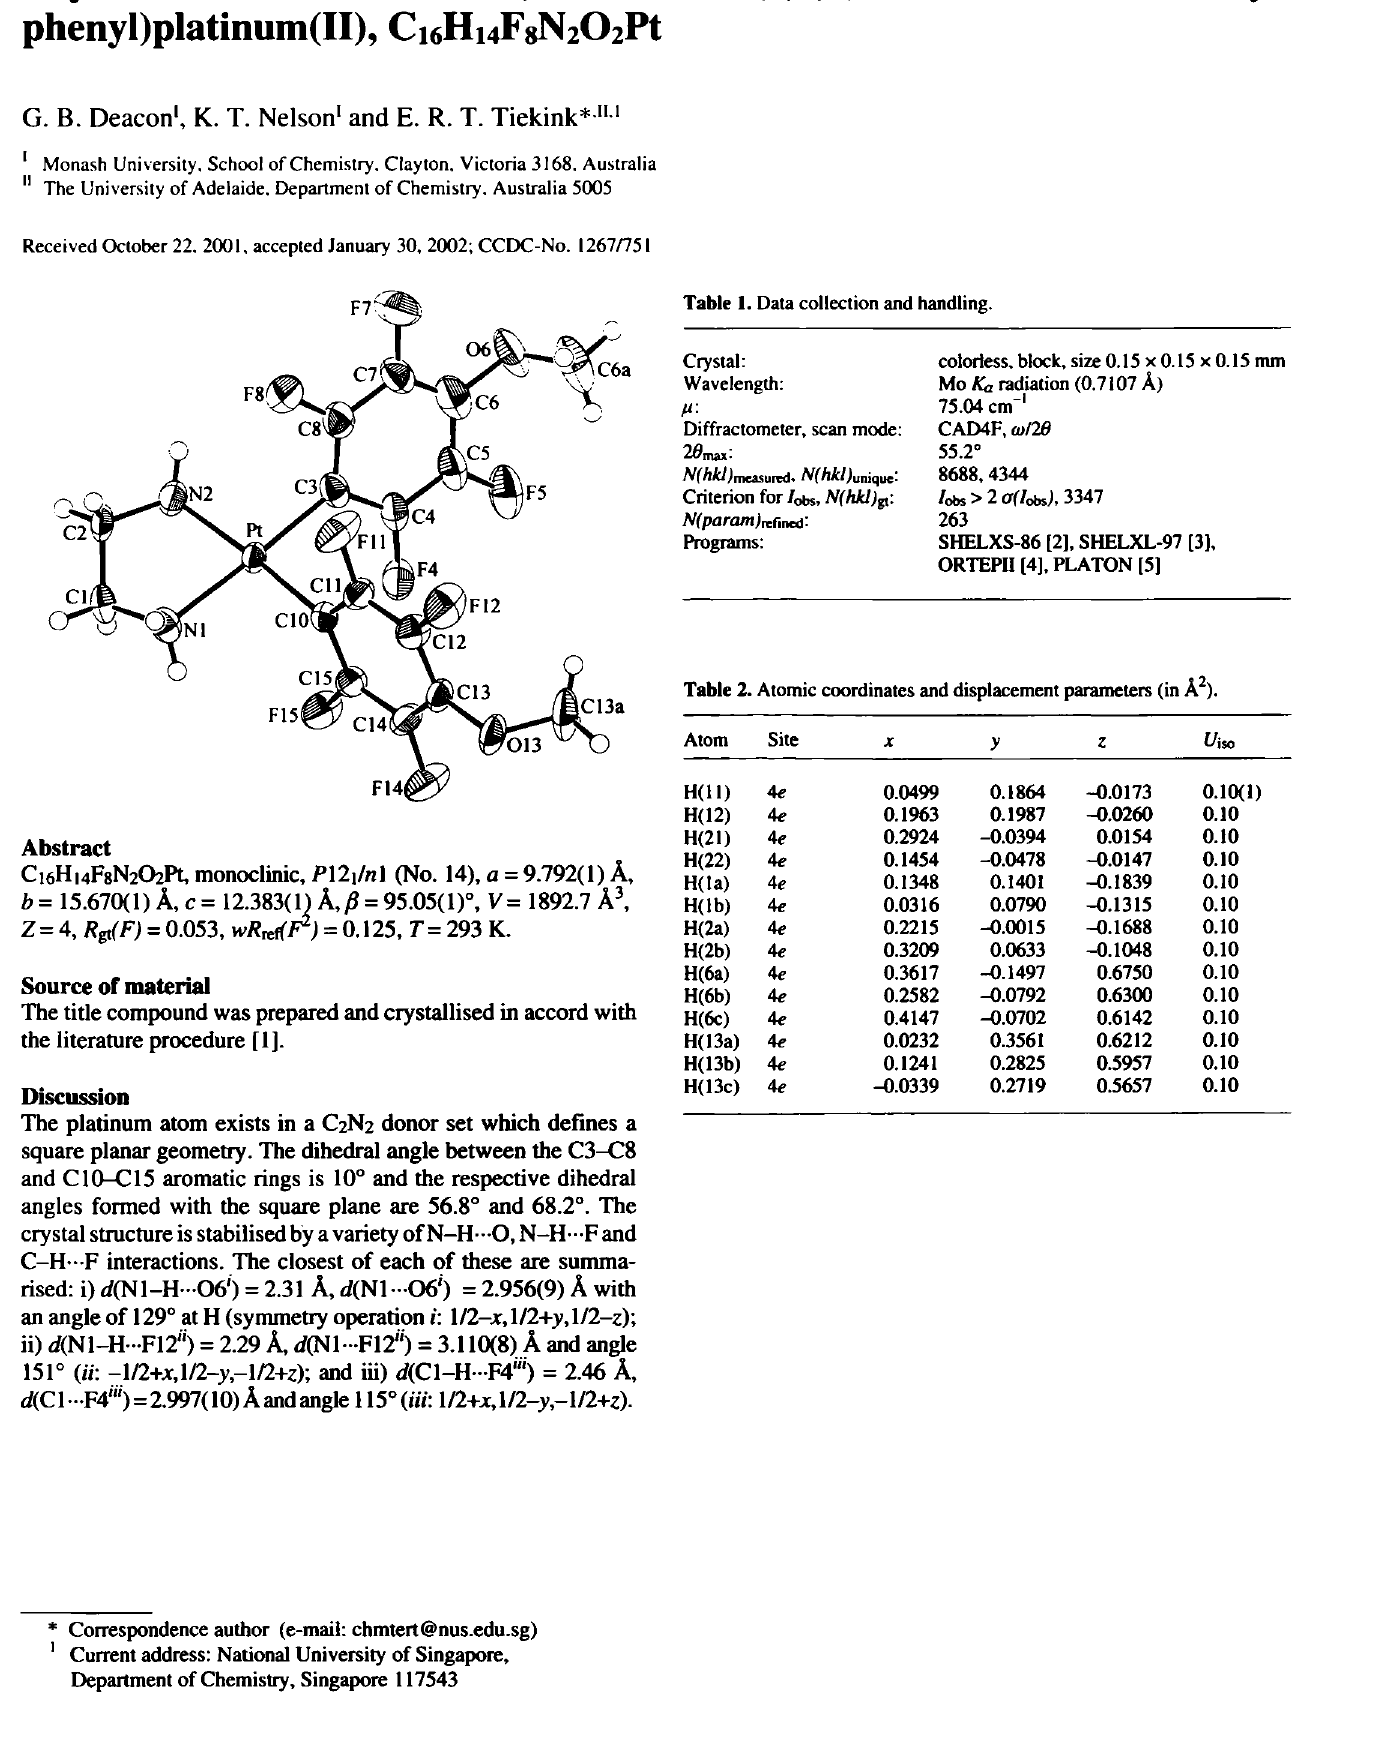
Table 1. Data collection and handling.